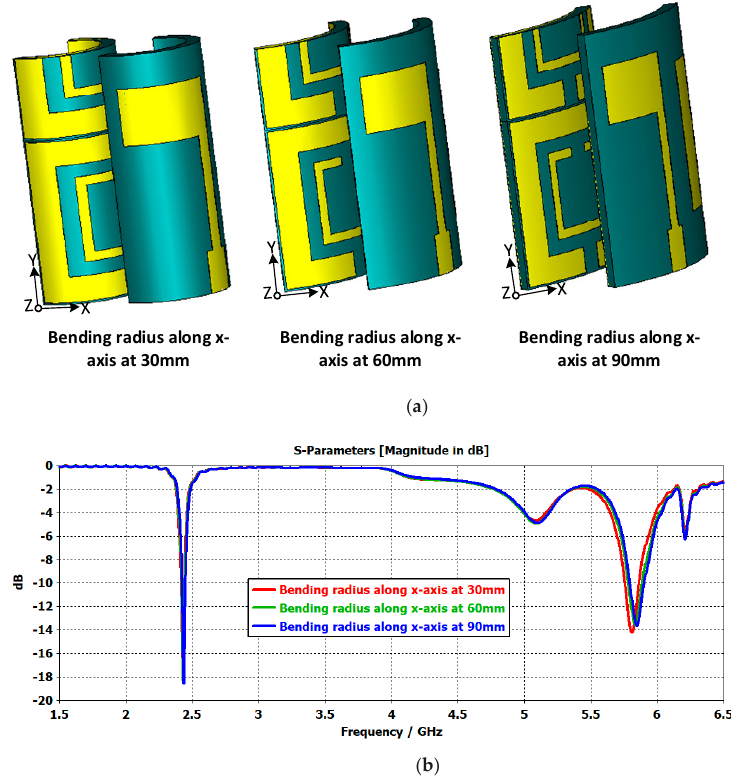
Figure 18. ( a ) Bending analysis of the AMC-backed antenna along the x -axis. ( b ) S 11 behavior at Bx = 30, 60, and 90 mm